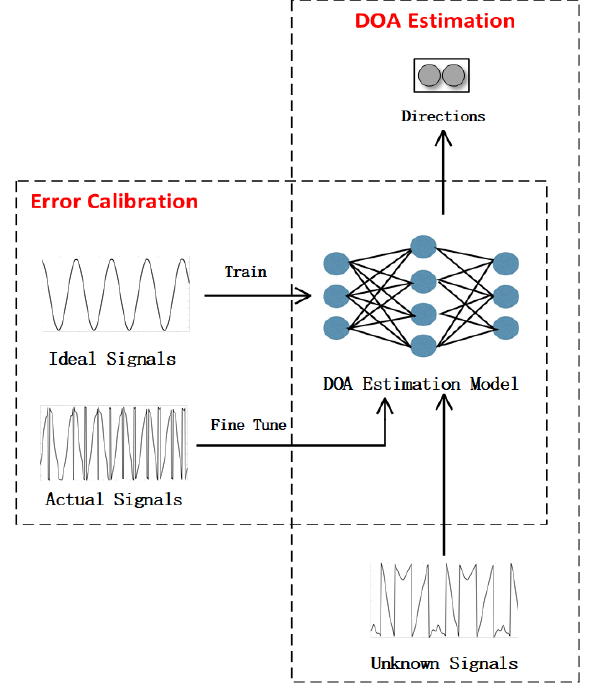
Figure 2. Error calibration method based on transfer